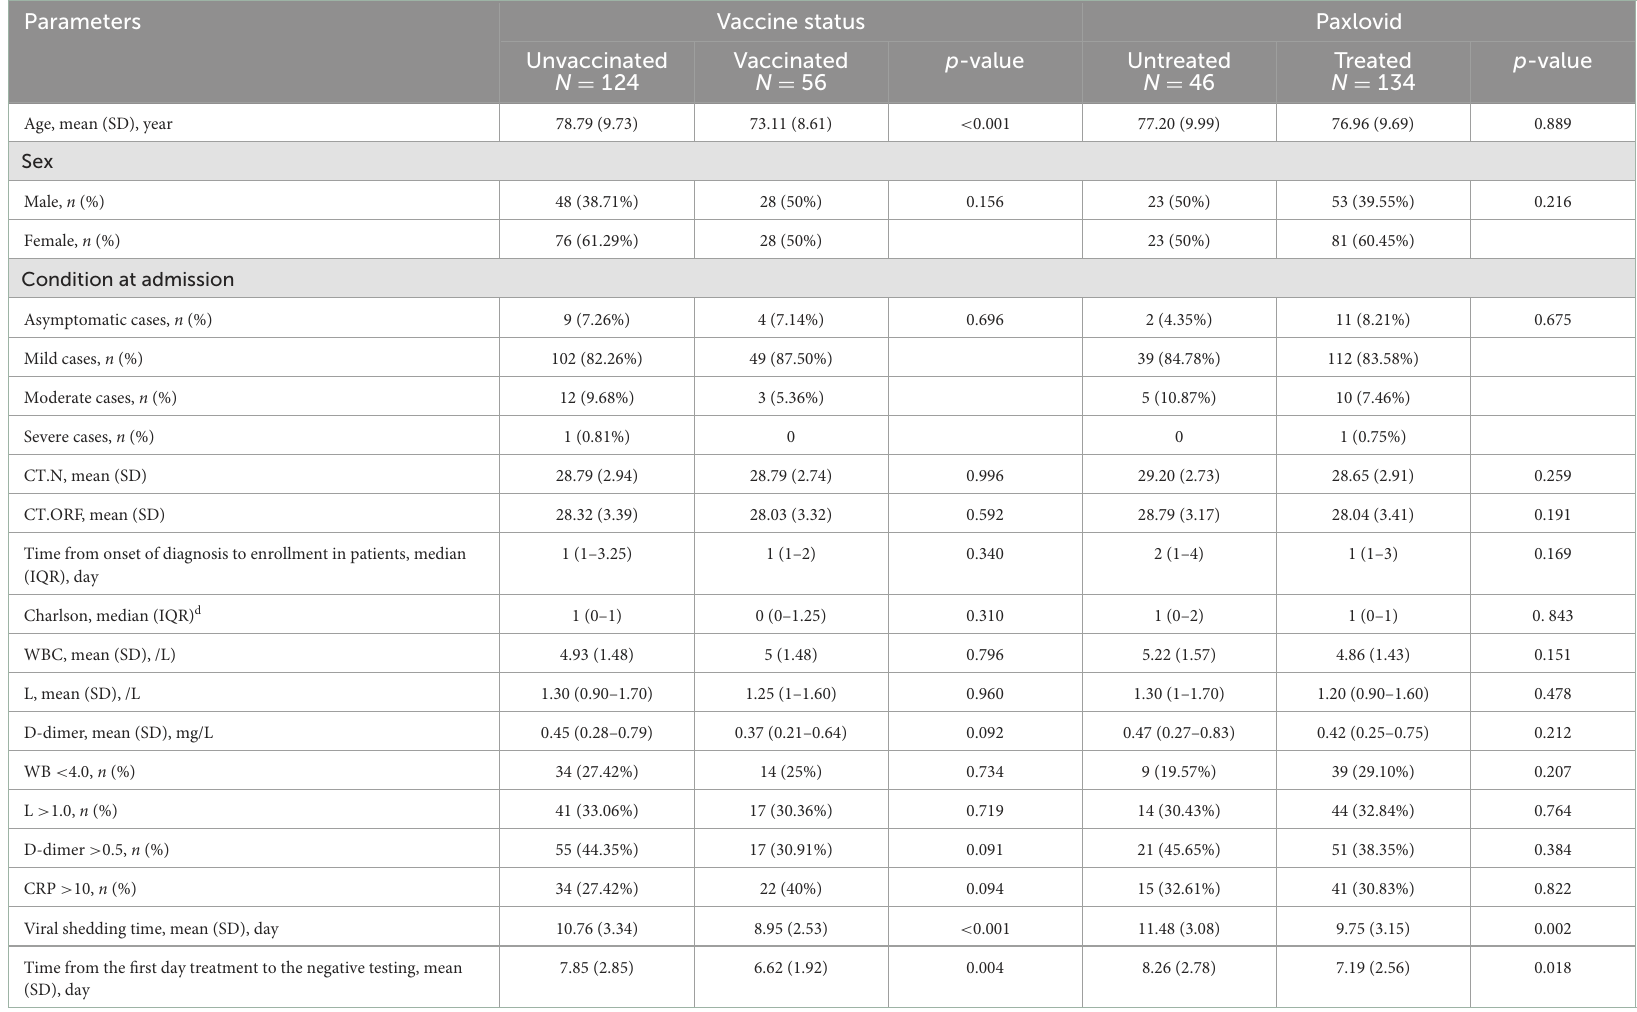
TABLE 3 Comparison of clinical characteristics between groups of vaccine status or paxlovid status. Parameters Vaccine status Paxlovid